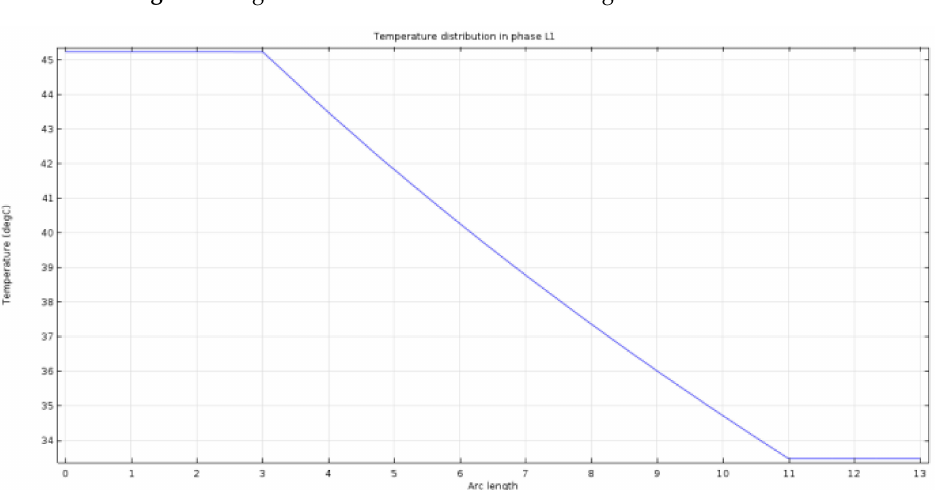
Figure 8. Temperature distribution along the segment AB shown in Figure